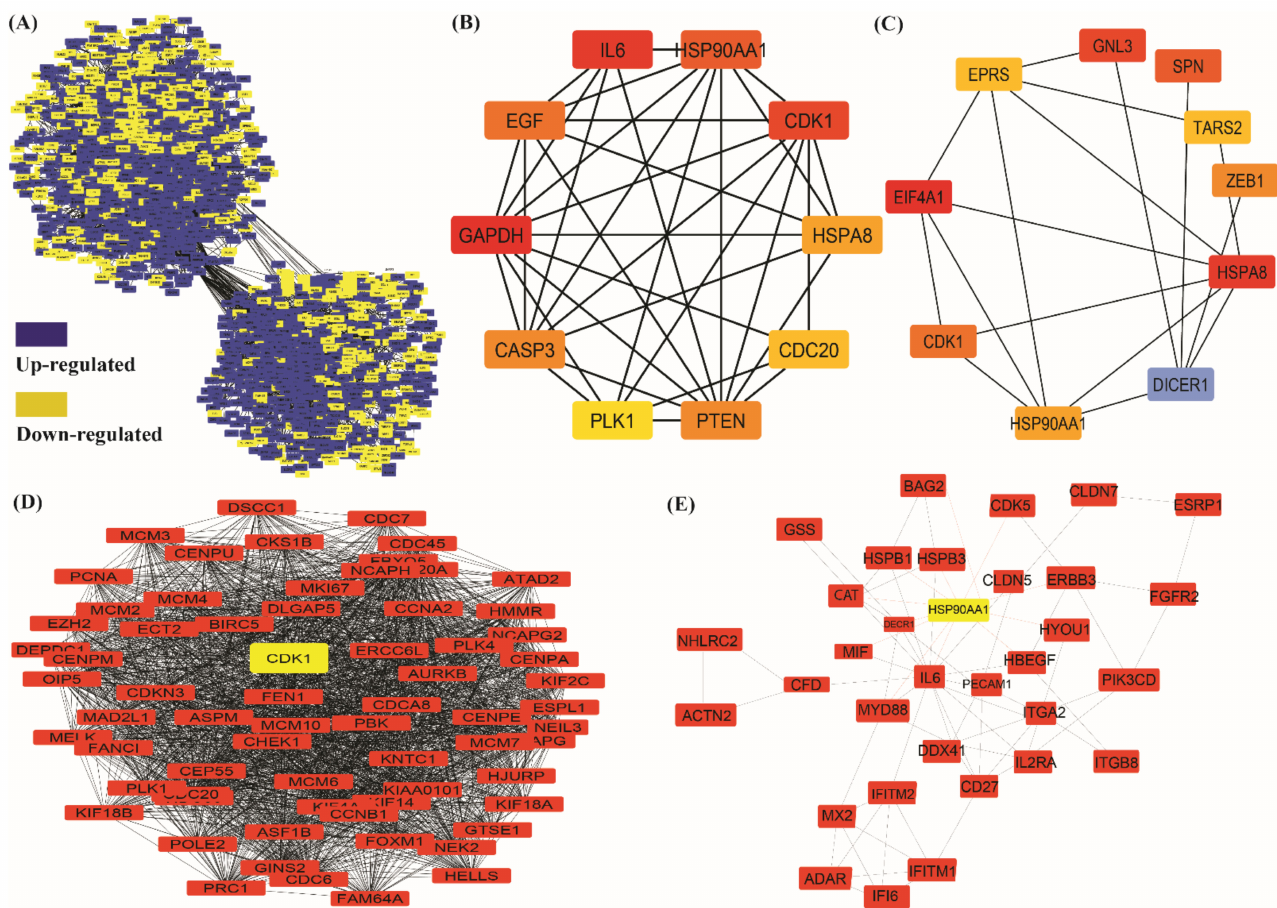
Figure 5. ( A ) Protein–protein network of DEGs. Blue color node showing upregulated genes and yellow color node showing downregulated genes of non-small cell lung cancer vs. normal. ( B ) Top-10 hub, and ( C ) bottleneck genes of PPI network retrieved from significant modules (dark color showing higher value in analysis, all are upregulated except the blue which represents down- regulated genes) ( D , E ) Top-two modules after integrated analysis of PPI network ( D ) Modules 1 ( E ) Module 2. Node showing genes, lines denoted interaction between